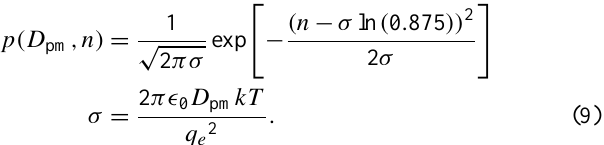
Fig. 32: Comparison of the performance of eight different multiple charge inversion routines. Shown are the differ- ent resulting PNSDs based on the very same EPMD, and their relative deviation to the new inversion routine. Repro-